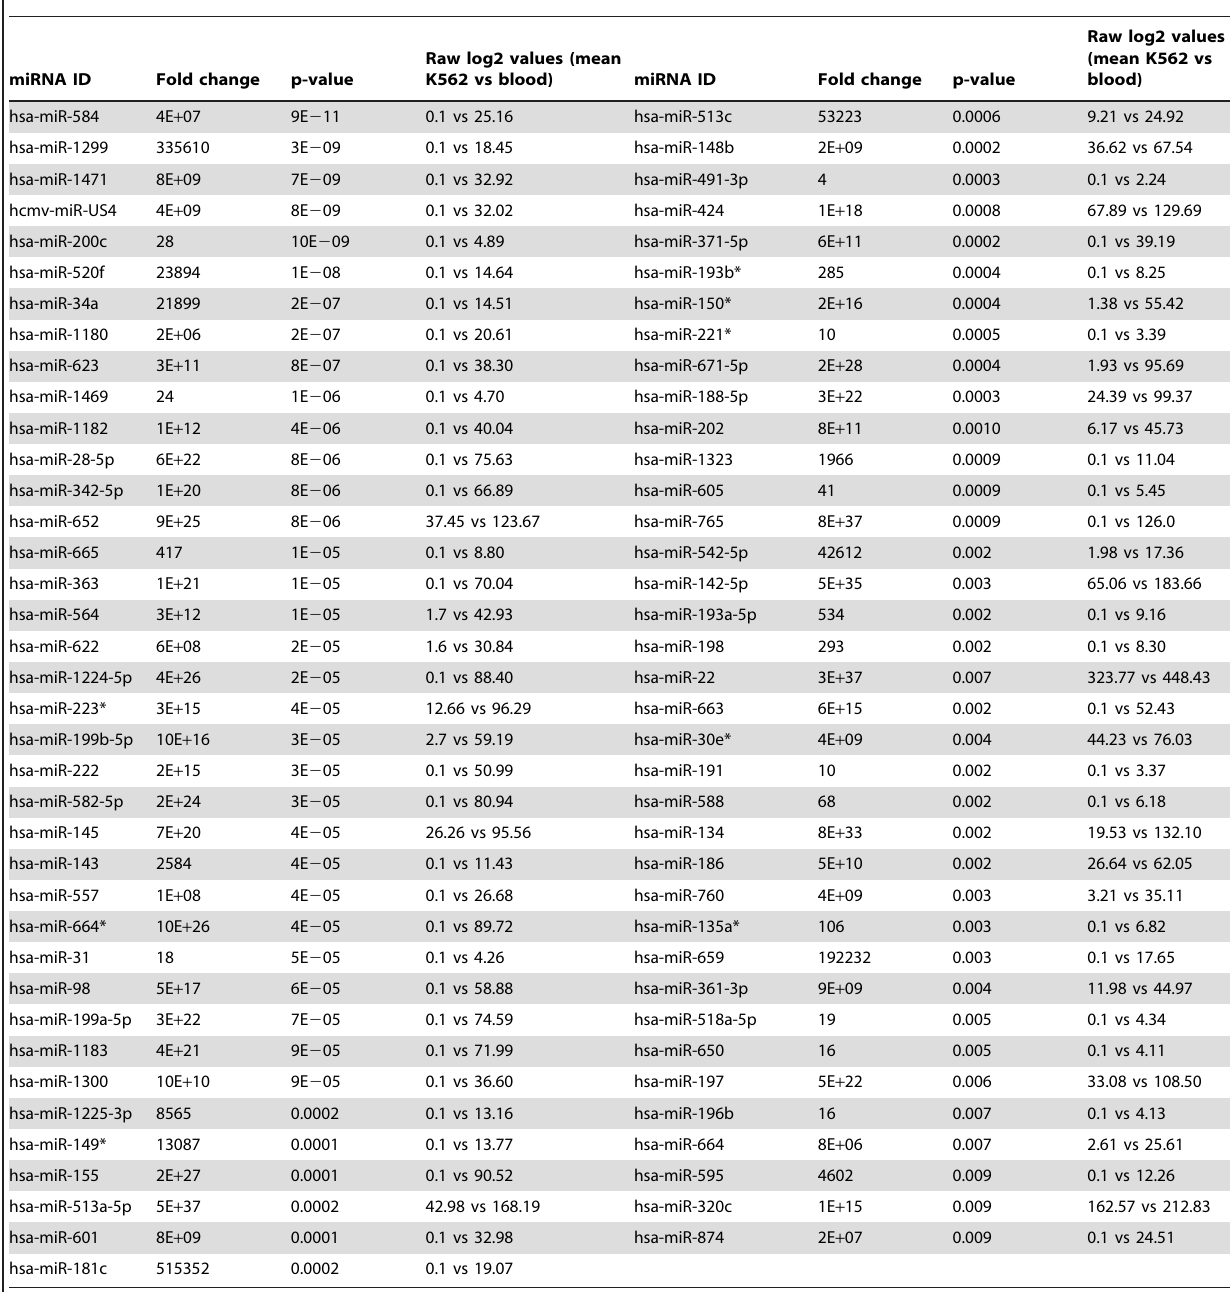
Shown is the fold change difference expression of K562 cells compared to healthy blood samples (second column from left), and p-value (third column from left), for each presented miRNA (first column from left). The last column displays raw experimental expression data presented as log2 values (0.1 is background